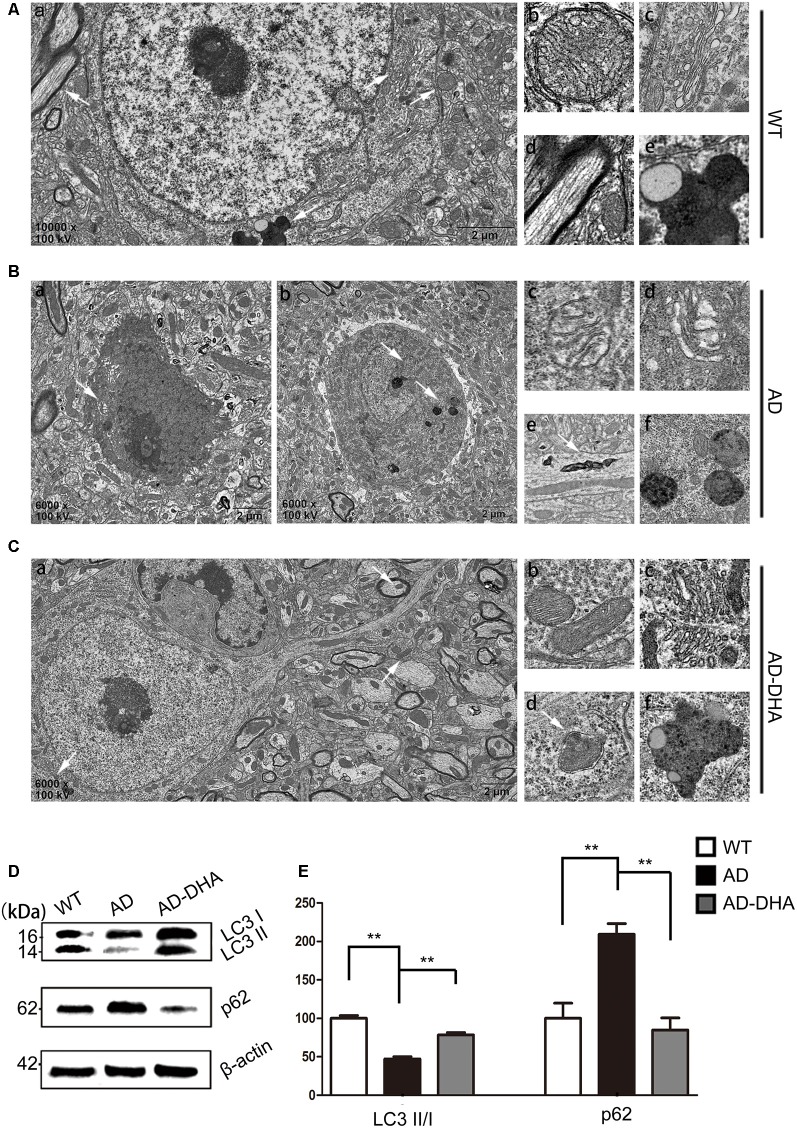
Oral DHA protects the ultrastructures of hippocampal neurons and normalizes autophagic flux. (Aa,Ba,b,Ca) Low magnification images of CA1 hippocampal neurons in the three groups were detected by transmission electron microscopy (TEM). Normal mitochondria (Ab), Golgi apparatus (Ac), microtubules (Ad), and granules of lipofuscin with lipid droplets (Ae) in the cytoplasm of neurons of WT mice (white arrows in Aa). Abnormal mitochondria (Bc), Golgi fragments (Bd), aberrant myelin figures (Be), and late autophagosome deposits (Bf) in the neurons of the DMSO-treated AD group (white arrows in Ba). Intact mitochondria (Cb), Golgi apparatus (Cc), early autophagosomes (Cd), and granules of lipofuscin with lipid droplets (Cf) in the cytoplasm of neurons of DHA-treated mice (white arrows in Ca). Scale bars
(Aa,Ba,b,Ca): 2 μm and (Ab–e,Bc–f,Cb–f): 350 nm. Levels of LC3, p62, and β-actin in extracts of whole brain tissue were detected by WB (D), and quantification of the results is shown in panel (E). **p < 0.01 between two groups. One-way analysis of variance/Newman–Keuls test was performed for all WB data.